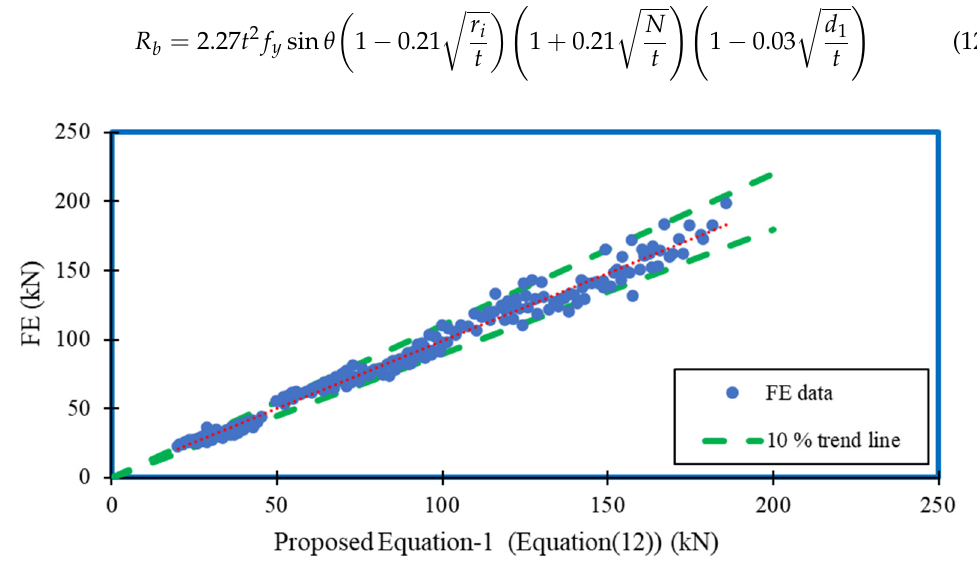
Figure 24. Comparison between parametric results and proposed Equation-1 (Equation (12)).